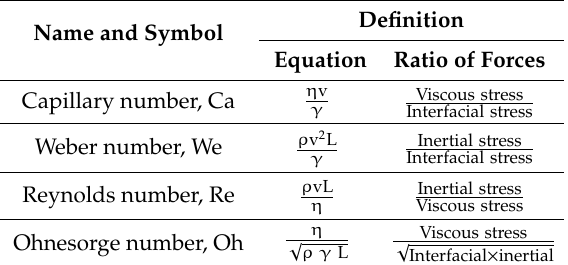
Table 1. Summary of dimensionless numbers and their